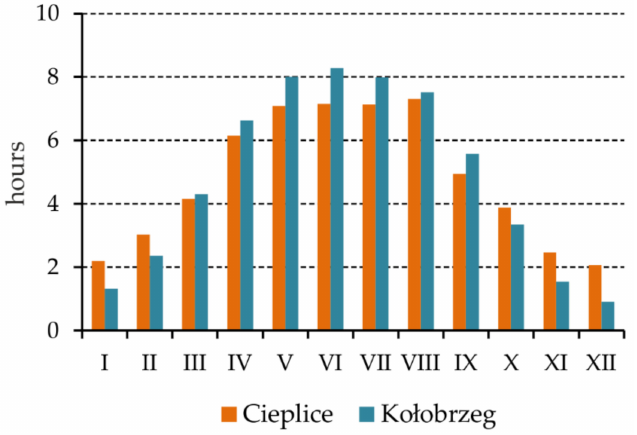
Figure 4. The annual course of the average daily amounts of actual sunshine duration in Cieplice and Kołobrzeg. Average values for months for the years